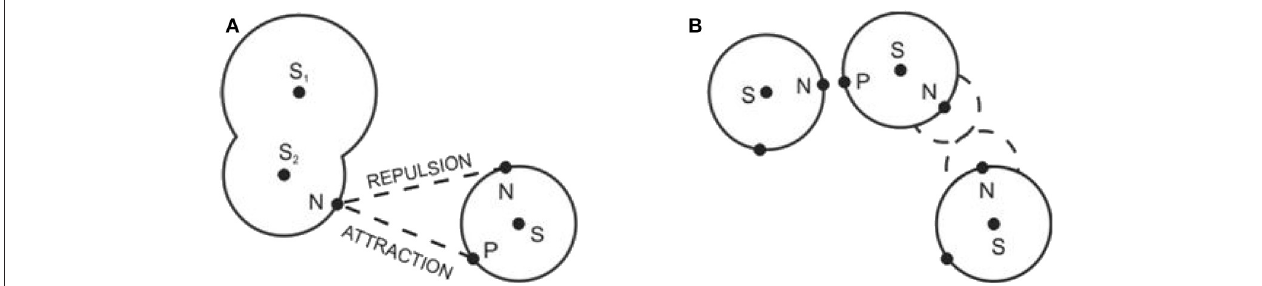
FIGURE 5 | Schematic representation of the site-site interaction in the primitive model (A) and the associated pseudohard body (B) . Symbols N and P denote the negatively and positively charged sites, resp. Reprinted with permission from Pure Appl. Chem. (2013) 85:201.